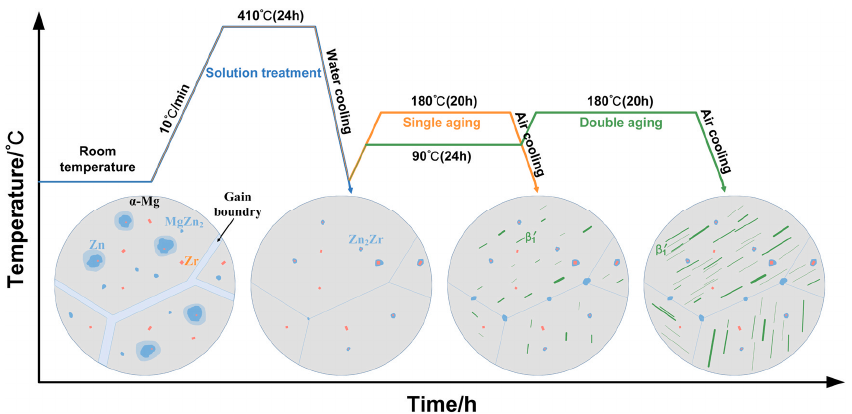
Figure 12. Schematic illustration of the microstructure evolution of LPBF ZK60 Mg alloy during different heat treatments. Reprinted with permission from ref. [83]. Copyright 2022